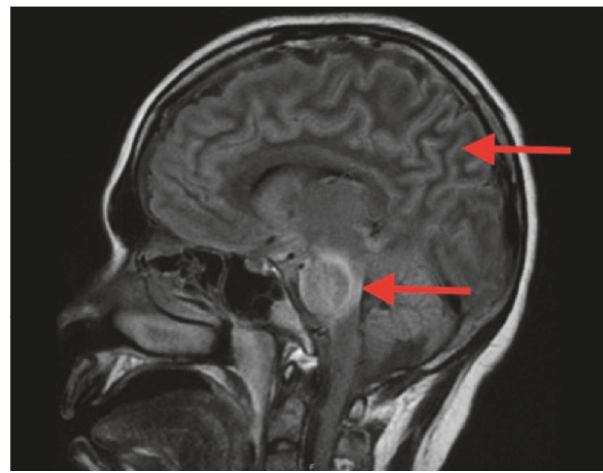
Figure 2: T2-FLAIR Sagittal image showing diffuse pontine edema and cerebral